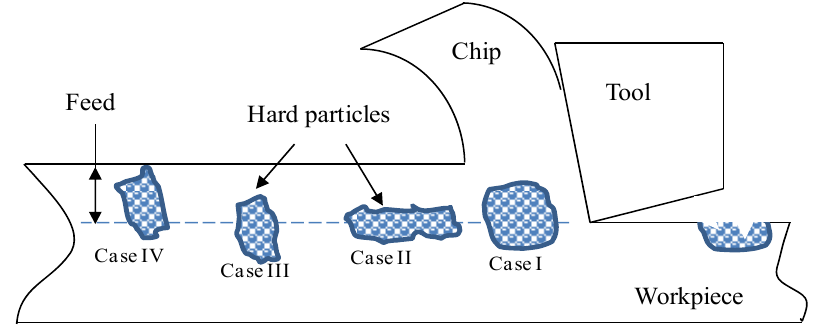
Figure 13. Illustration of mechanisms of surface damage induced by tool/hard particle interaction.